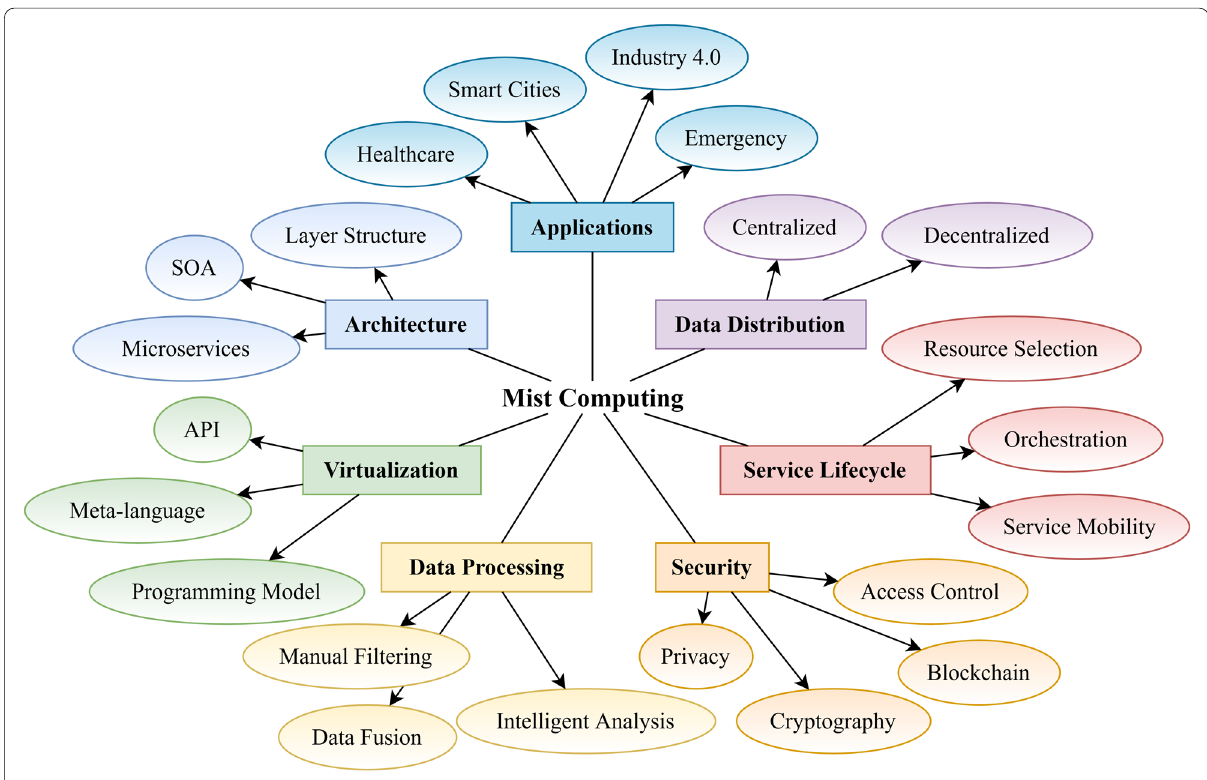
Fig. 4 Research working areas in Mist